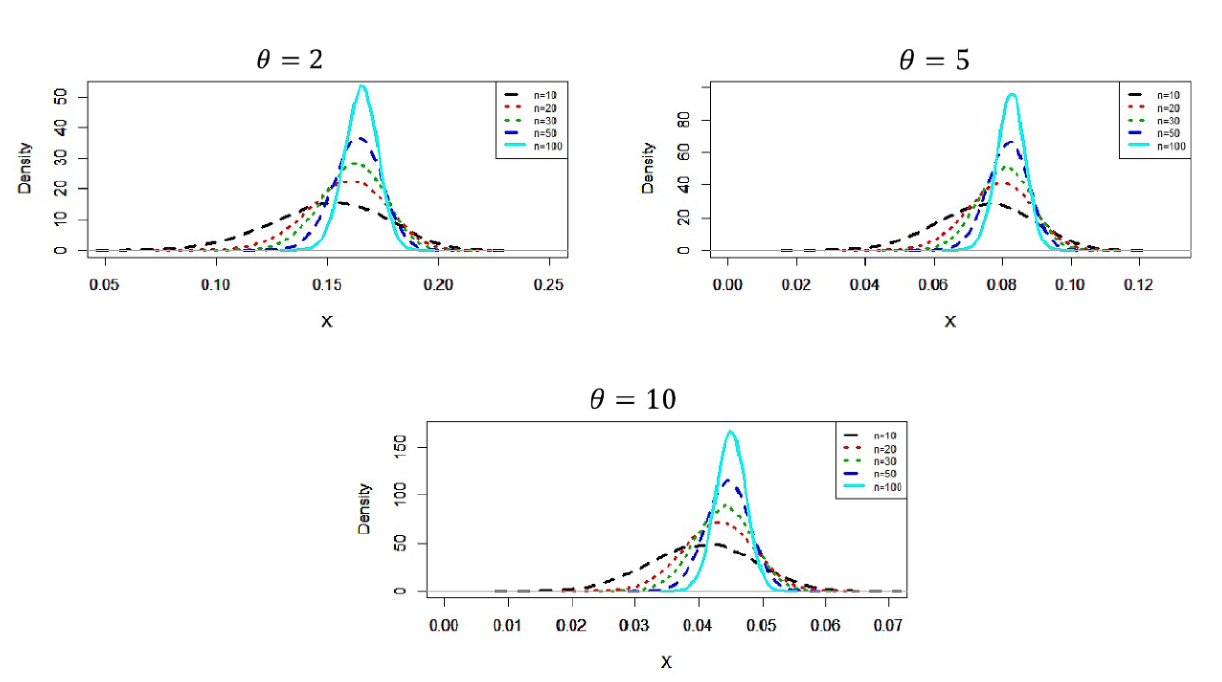
Figure 2. The estimated PDFs of R n ( θ ) under U ( 0,1 ) , for 0 < θ < 1.